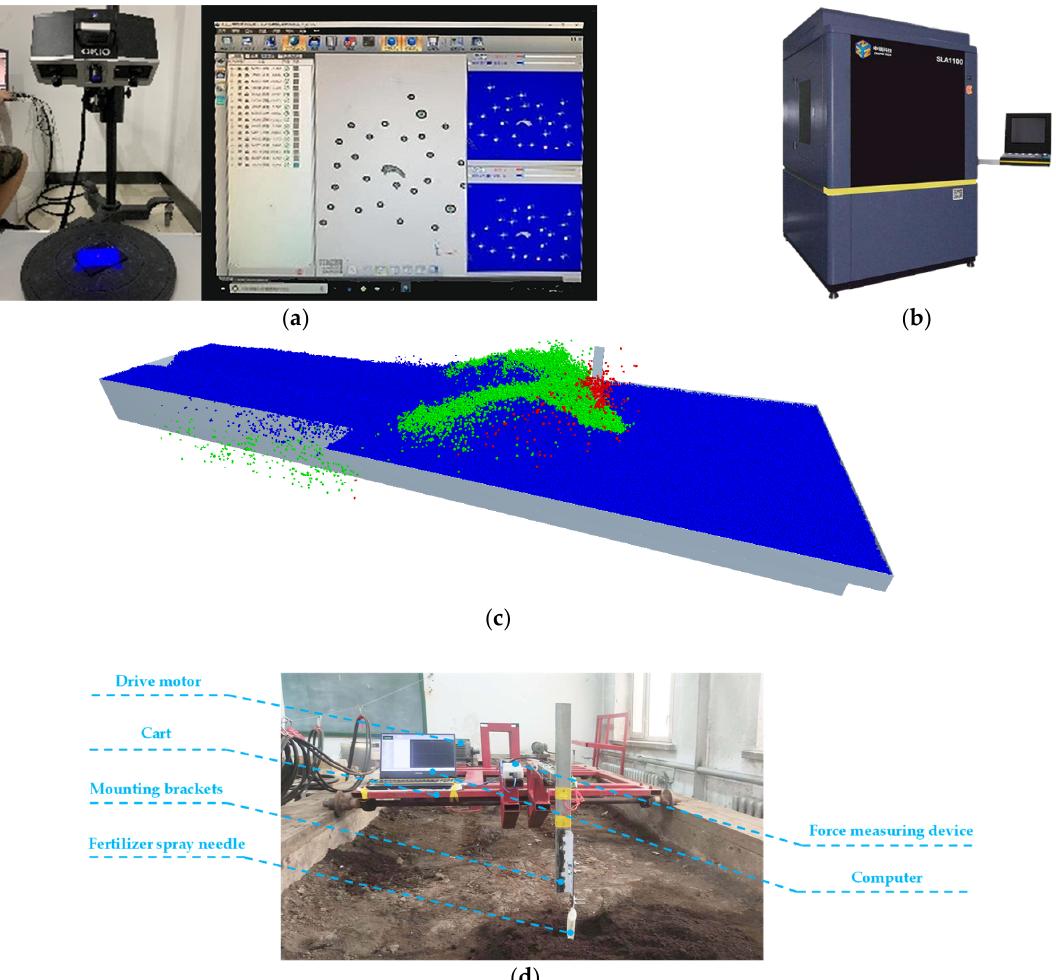
Figure 2. Schematic diagram of test equipment. ( a ) Industrial-grade 3D scanner; ( b ) laser sintering 3D printer; ( c ) DEM virtual simulation test process; ( d ) indoor soil bin test bench.